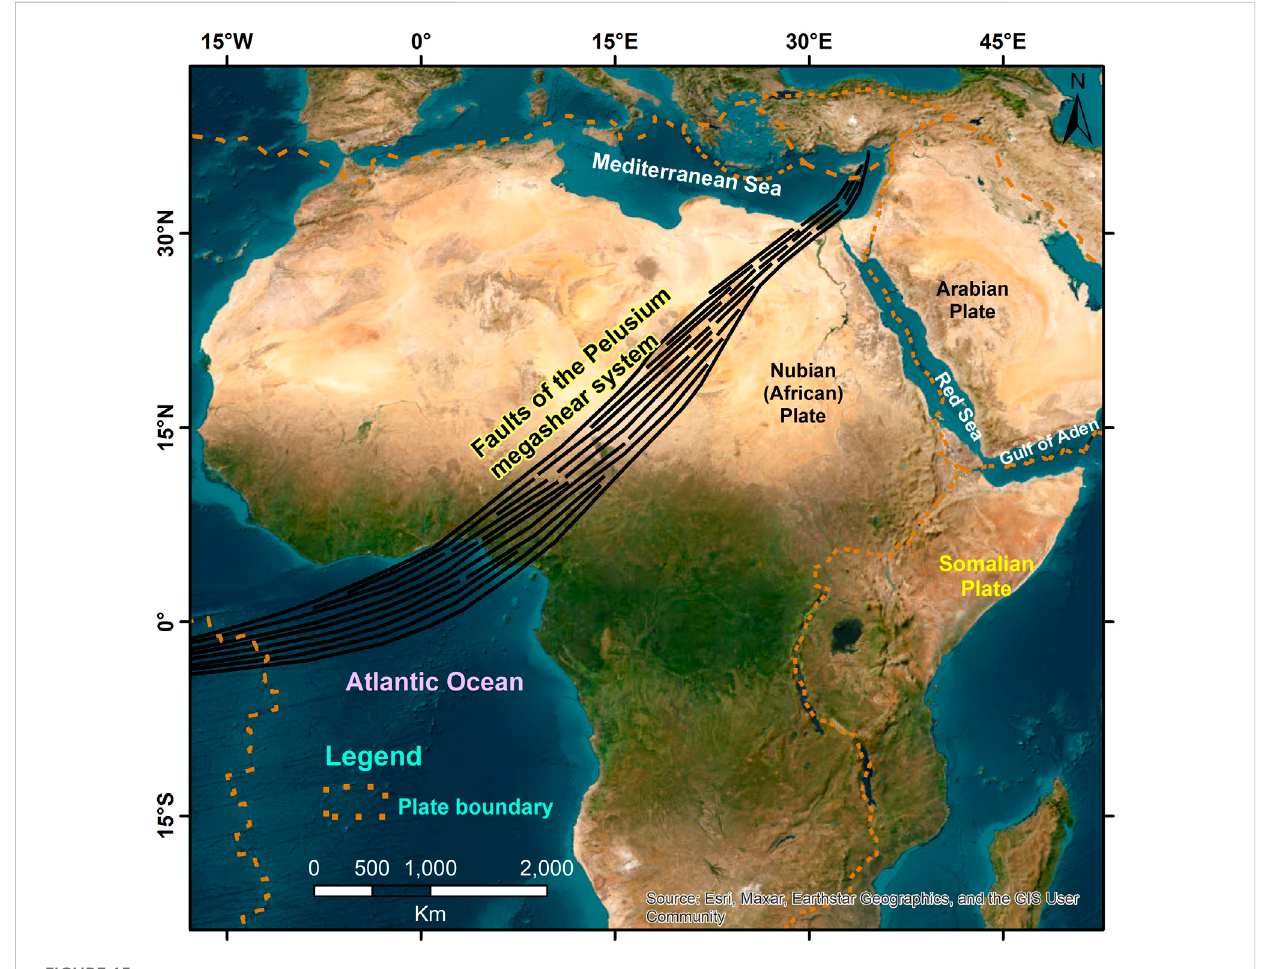
FIGURE 15 Distribution pattern of the faults of the PMS across Africa (Modi fi ed after Neev et al., 1982).